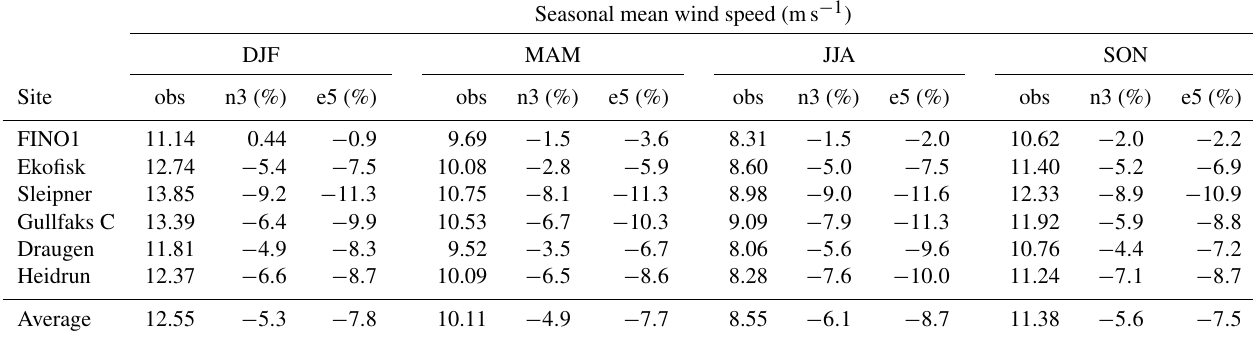
Table 2. Seasonal average of the observed (obs) wind speed (ms − 1 ) and the model deviation in percentage (%) for both NORA3 (n3) and ERA5 (e5). “DJF” corresponds to December–January–February, “MAM” is March–April–May, “JJA” is June–July–August, and “SON” is